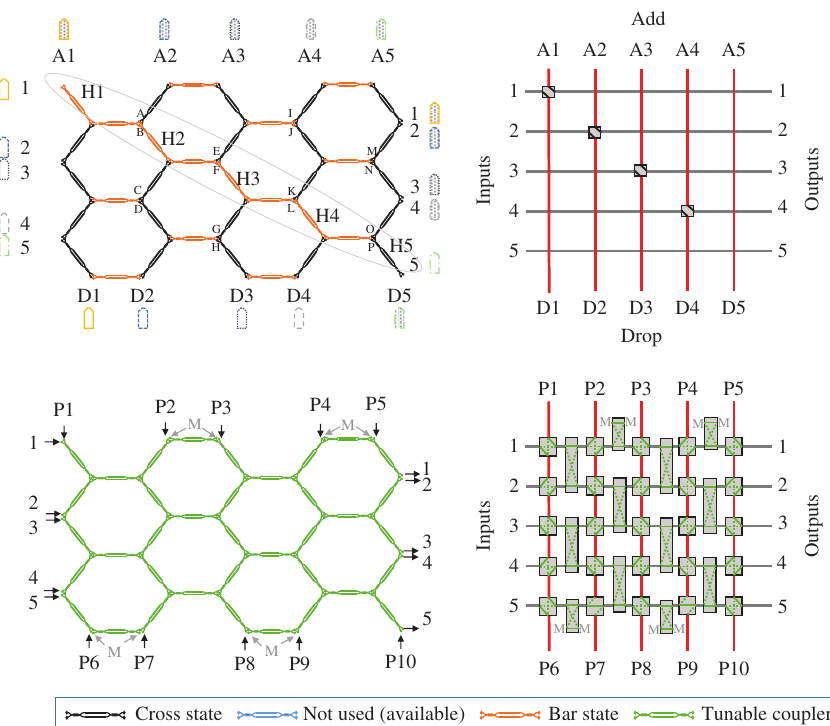
Figure 19: Waveguide mesh settings for channel management application: (upper) add-drop configurations for channels 1–4. Channel 5 bypasses the device. (Lower) Fully reconfigurable channel management station that allows channel broadcasting, add/drops, channel combinations and demultiplexing. M : signal monitoring